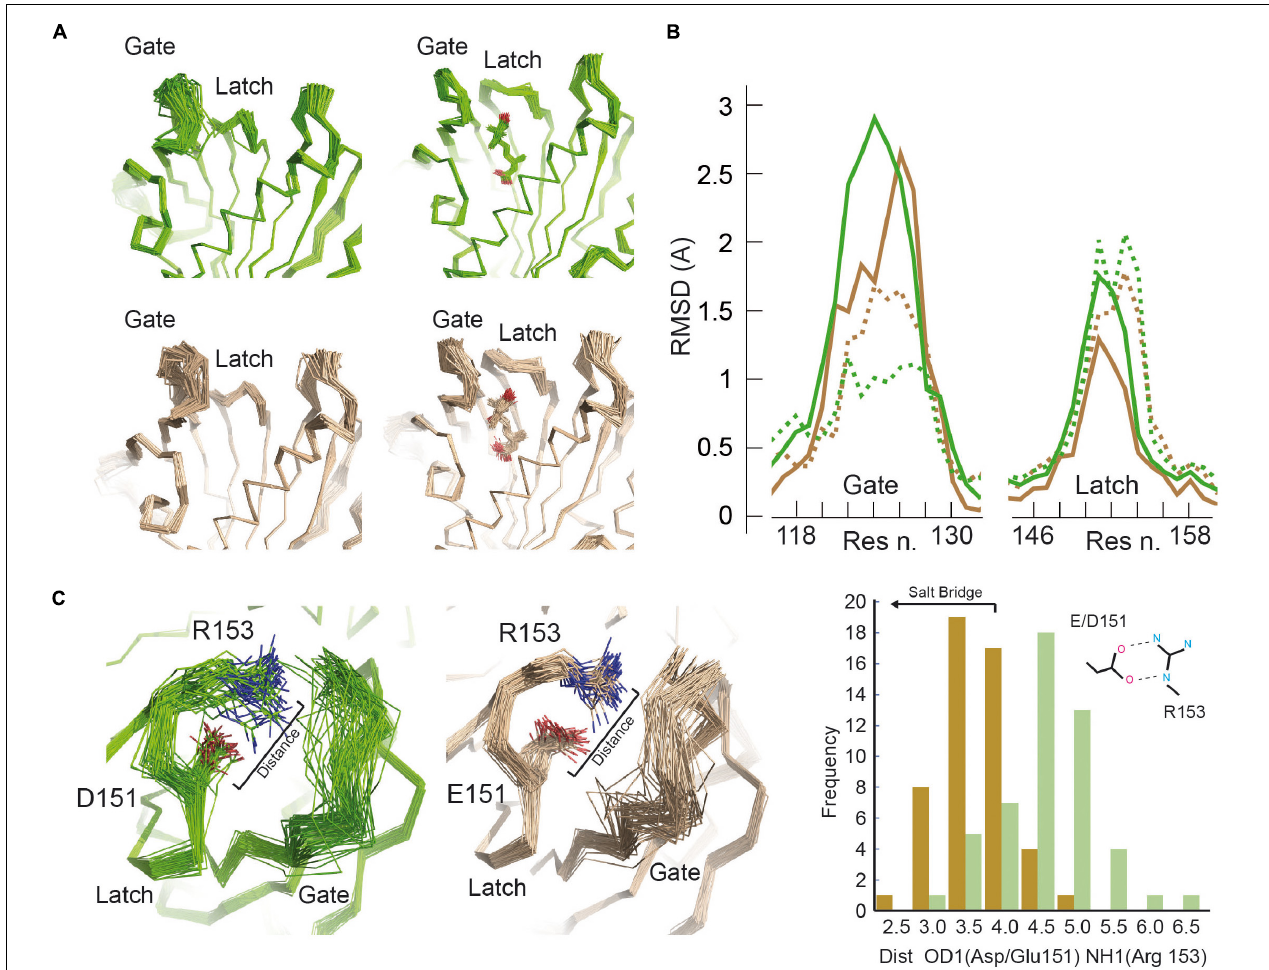
FIGURE 3 | Molecular motions of SlPYL1 E151D. (A) Overview of main chain dynamics of gate and latch in ensemble structures of the apo and ABA bound forms of SlPYL1 E151D (green) and SlPYL1 (wheat). (B) Main chain atomic root mean squared fluctuations at gate and latch of ensemble models of apo and ABA SlPYL1 E151D (solid and dashed green lines, respectively) and apo and ABA SlPYL1 (solid and dashed wheat lines, respectively). ( C ; Left) Side chain dynamics of residues conforming the salt bridge between Glu/Asp 151 and Arg 153 of the apo forms of SlPYL1 E151D (green) and SlPYL1 (wheat). (Right) Panel showing the corresponding minimum distance between Asp (green) or Glu 151 (wheat) carboxylate oxygen atoms and Arg 153 guanidinium nitrogen atoms